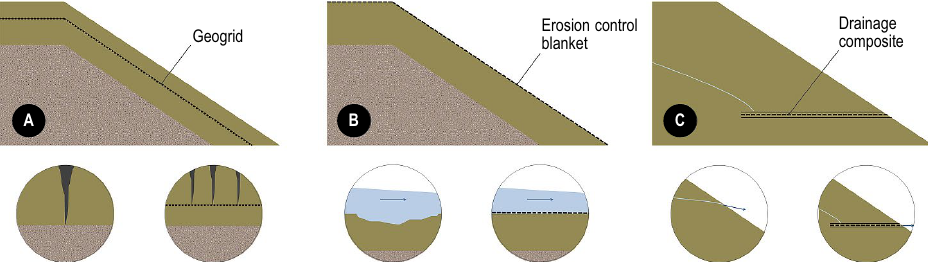
Fig. 2. Schematic cross-sections: (A) Sand core & geogrid reinforced dredged material cover. Without geogrid large cracks. With geogrid more smaller cracks not exceeding the geogrid; (B) Sand core & erosion protected dredged material cover. Without erosion control blanket surface erosion due to overflowing. With erosion control no erosion is expected; (C) Homogenous dike with geosynthetic drainage composite. Without composite seepage may occur on the inner slope. With composite defined